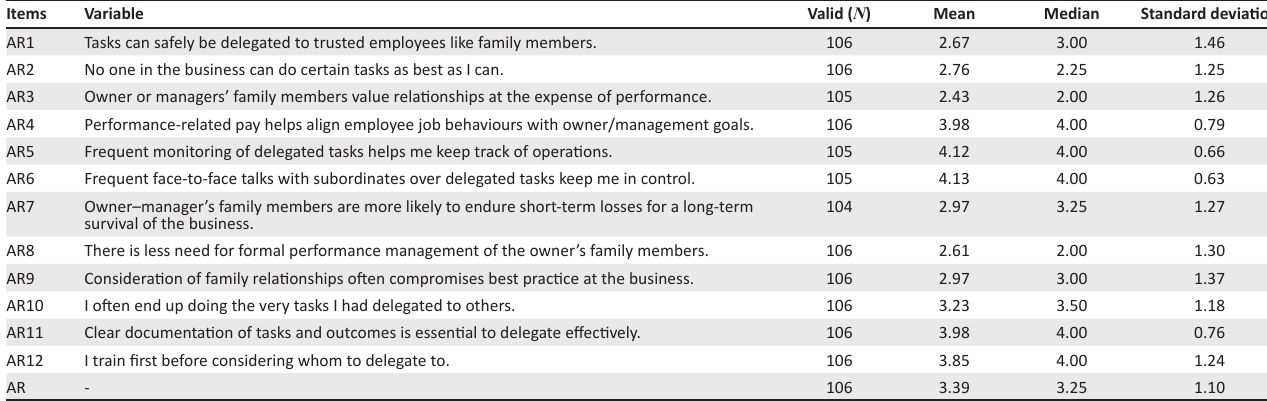
TABLE 2: The nature of agency control.